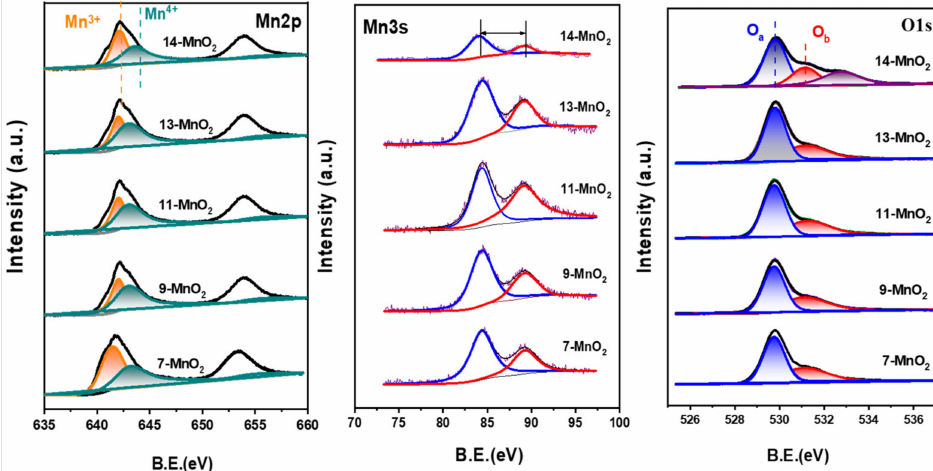
Figure 7. Mn2p, Mn3s, and O1s XPS spectra of the catalysts. Table 3. Composition of manganese and oxygen elements on the surface of the catalyst.